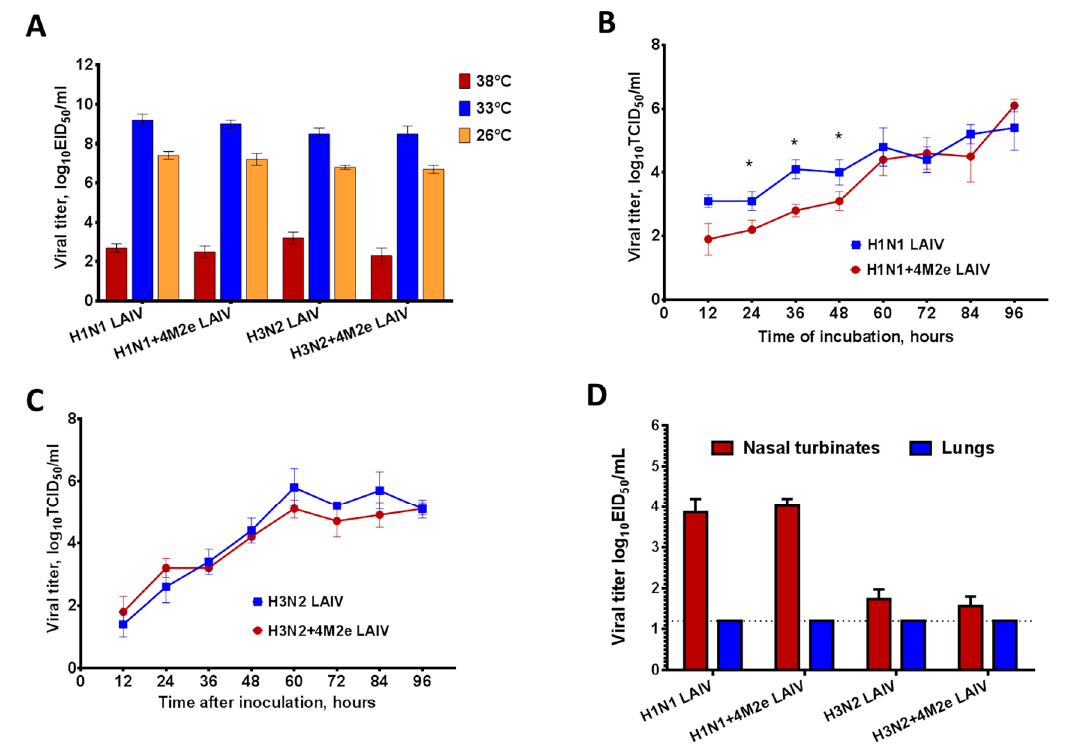
Figure 2. Replication of LAIV reassortants in vitro and in vivo. ( A ) Viral titers in eggs at different incubation temperatures. ( B ) Kinetics of virus growth of H1N1 LAIVs in Madin–Darby Canine Kidney (MDCK) cells at MOI 0.01. ( C ) Kinetics of virus growth of H3N2 LAIVs in MDCK cells at MOI 0.01. ( D ) Replication of LAIV viruses in mouse respiratory tract at day 3 post inoculation (H1N1 LAIVs and H3N2 LAIVs were administered at doses 10 6 EID 50 and 10 7 EID 50 , respectively). Data were compared with the Mann–Whitney U-test (* p < 0.05),